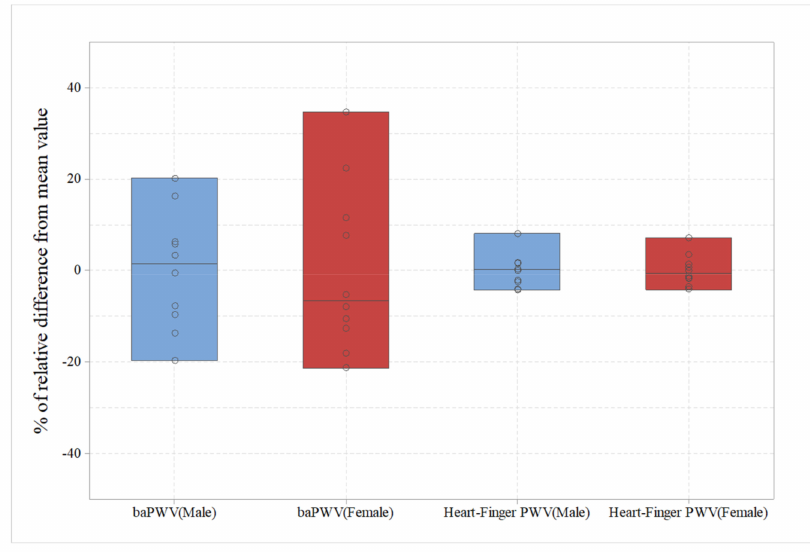
Figure 9. Relative data ranges according to PWV measurement methods and